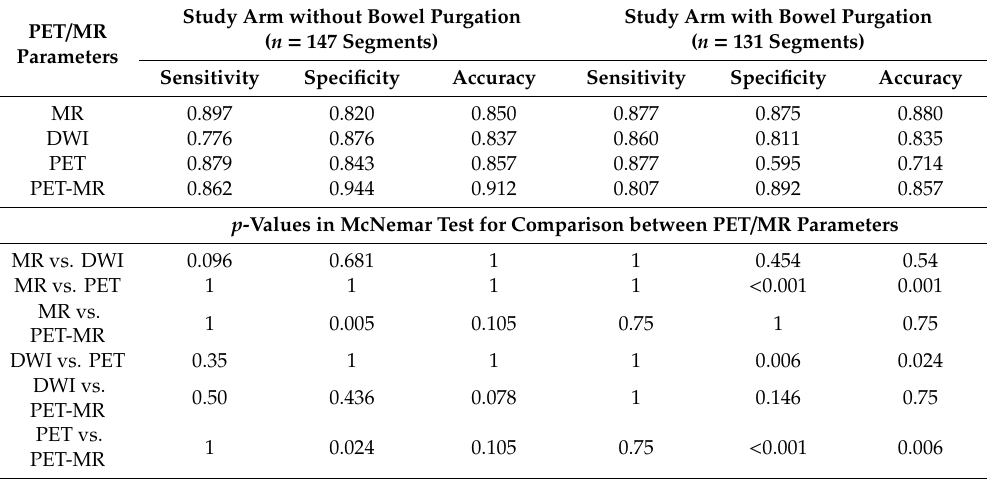
Table 2. Diagnostic performance of [ 18 F]-FDG-PET / MR enterography in study arms with and without bowel